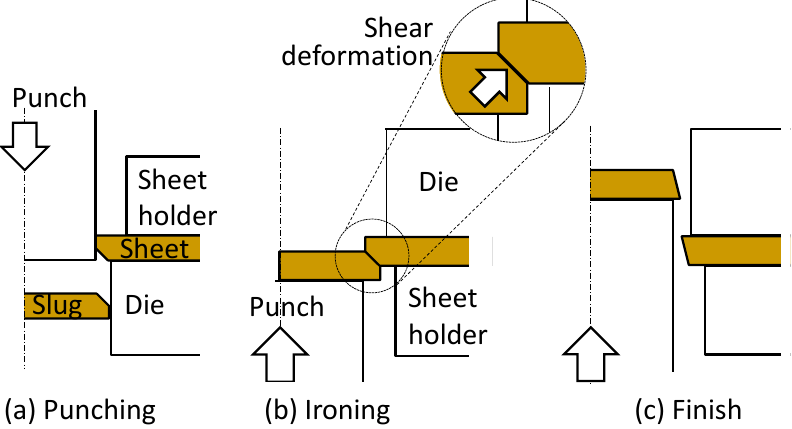
Figure 7. Ironing process of punched edge with slug ejected from punching; ( a ) punching, ( b ) ironing ( c ) finish.